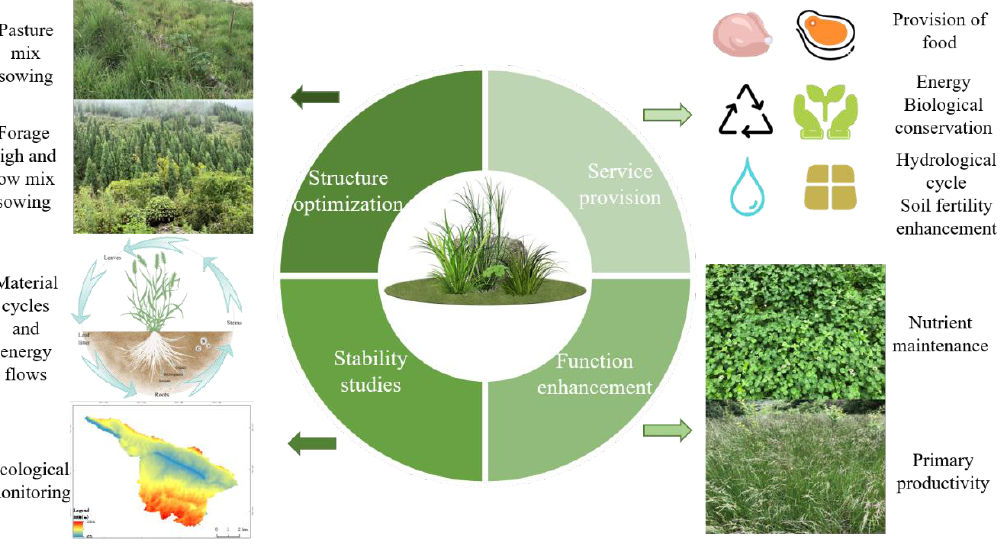
Figure 6. Processes of energy and service flows in grassland ecosystems (structure affects stability and thus changes the level of function and ultimately service